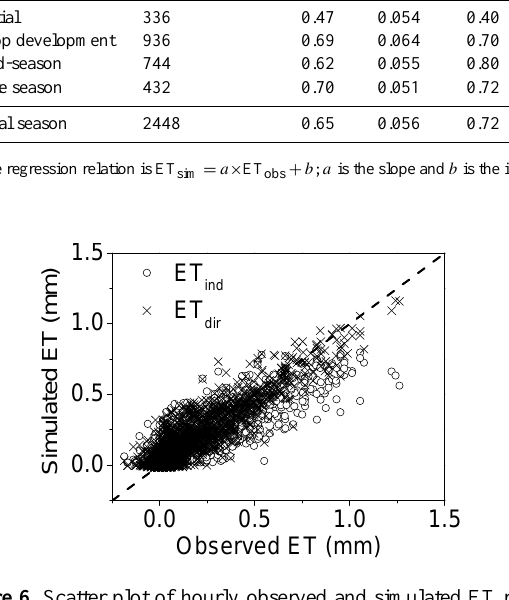
Figure 6. Scatter plot of hourly observed and simulated ET rates, with × being estimations using the ET dir method and ◦ being esti- mations using the ET ind